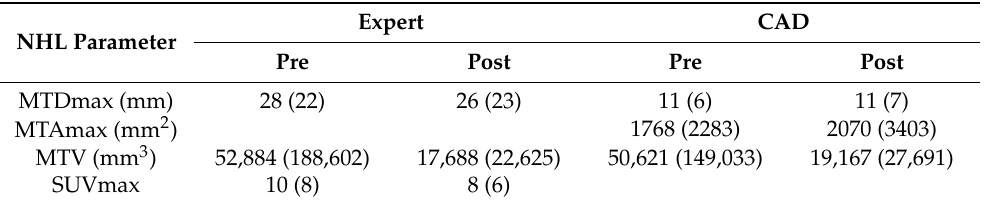
Table 2. Average PET metabolic parameter measurements and standard deviations (in parentheses) pre and post treatment for the NHL cases.